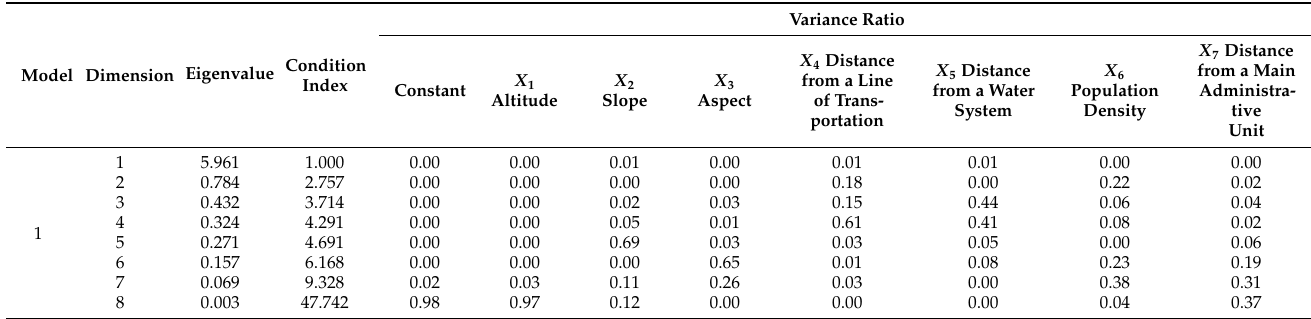
Table 7. Collinearity